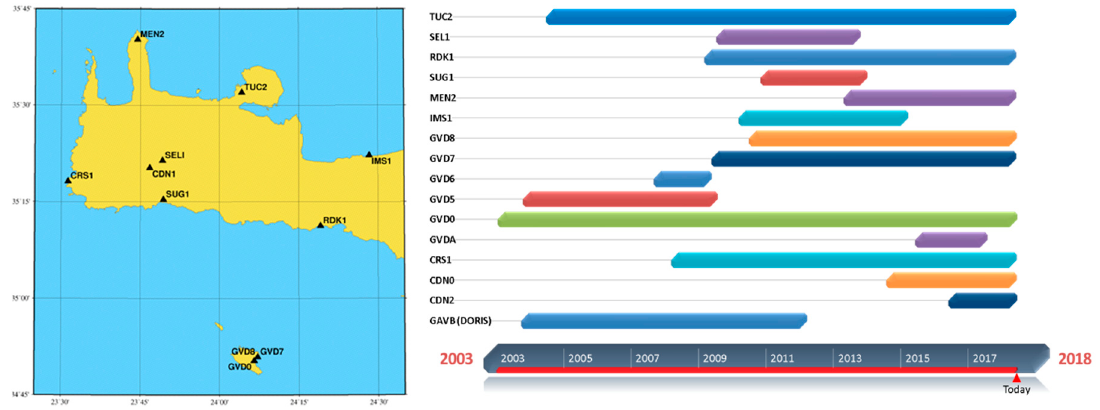
Figure 6. The regional GNSS network in Gavdos and west Crete, Greece ( left ) and availability of GNSS observations ( right ) .